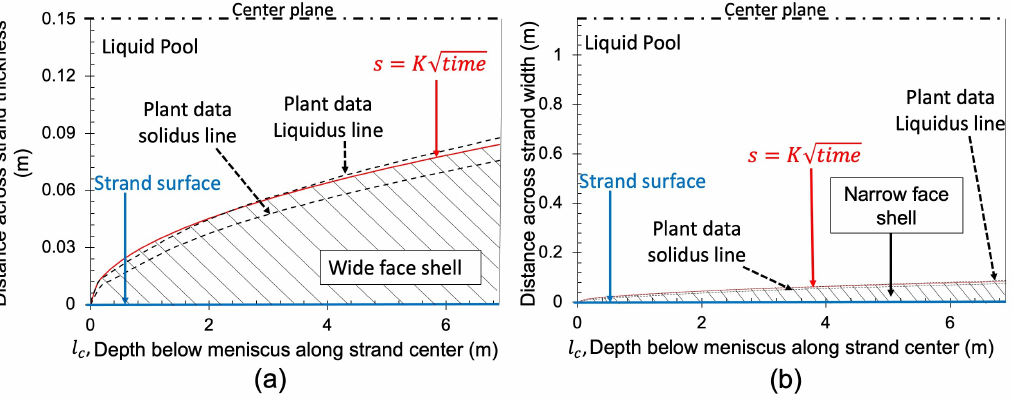
Figure 3. Shell thickness profile: ( a ) on the wide face (WF); ( b ) on the narrow face